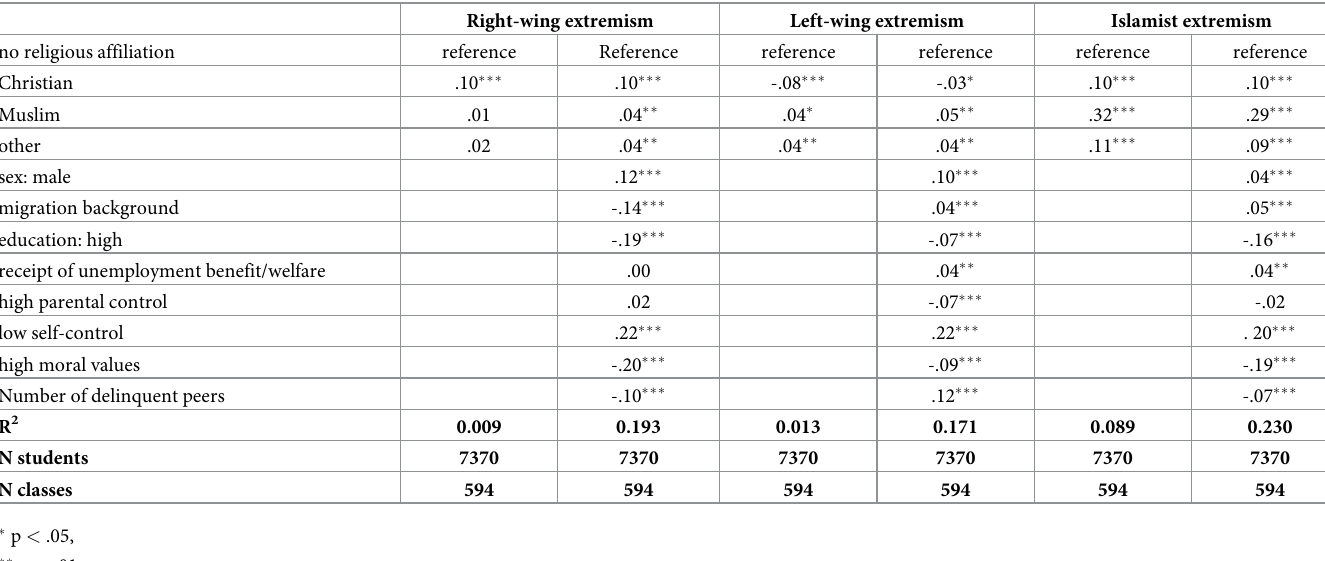
Table 6. Multilevel linear regression of religious affiliation on extremism attitude scales (standardised coefficients shown; estimator